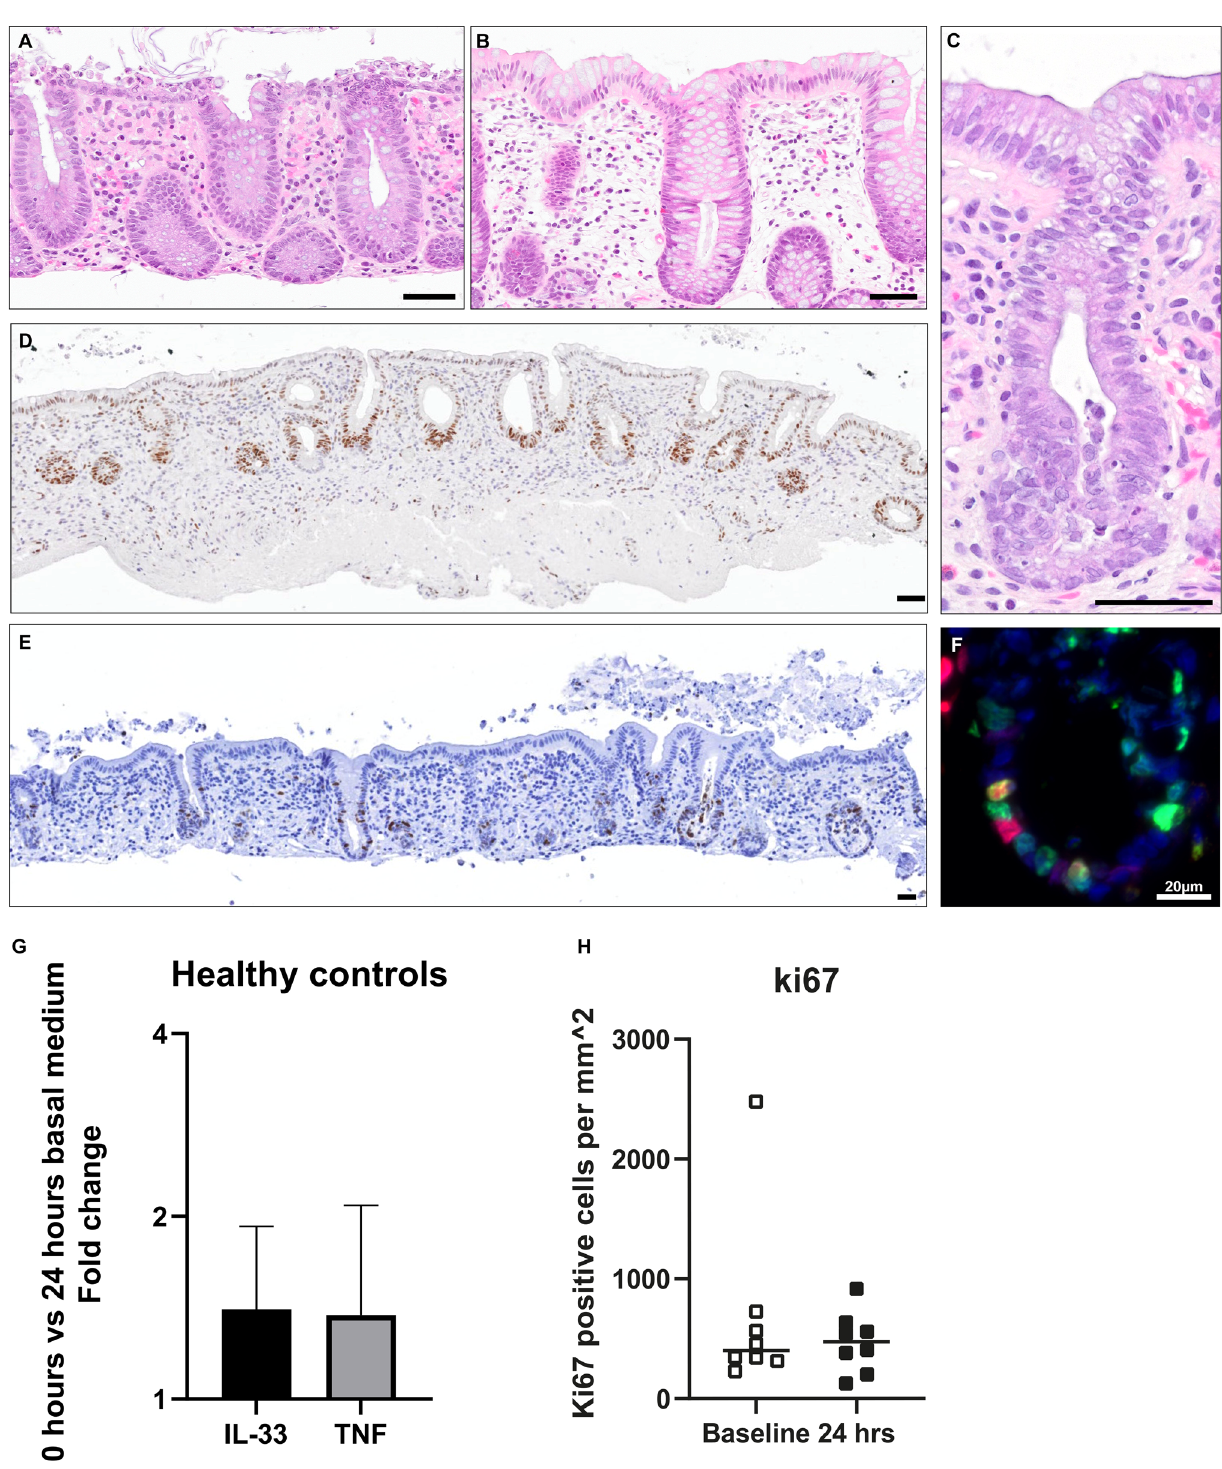
Figure 2. Ex vivo colonic biopsy model . Endoscopic pinch biopsies taken from the sigmoid colon were used in an ex vivo biopsy model. Images ( A–C) show hematoxylin and eosin staining of biopsies from healthy controls following 24 h in basal medium. Image ( D) shows a biopsy from quiescent UC (Mayo score ≤ 2) stimulated with IFN-gamma 100 ng/ml for 24 h in the basal medium. Immunoenzymatic staining confirms a strong signal of pSTAT1 (brown) in the epithelial border confirming good uptake of IFN-gamma to the epithelium. In image ( E) the proliferative cell marker Ki67 (brown) was detected with immunostaining in healthy controls at baseline and following 24 h with no significant change in expression shown in graph ( H) . In image ( F) dual-staining for IL-33 (red) and Ki67 (green) revealed IL-33 presence also in Ki67 positive cells (yellow). RT-qPCR was performed for IL33 and TNF in healthy controls comparing baseline (0 h) with 24 h incubation in basal medium. No significant differences were seen ( IL33 p-value = 0.3, TNF p-value = 0.8) shown in graph G . Scale bars = 50